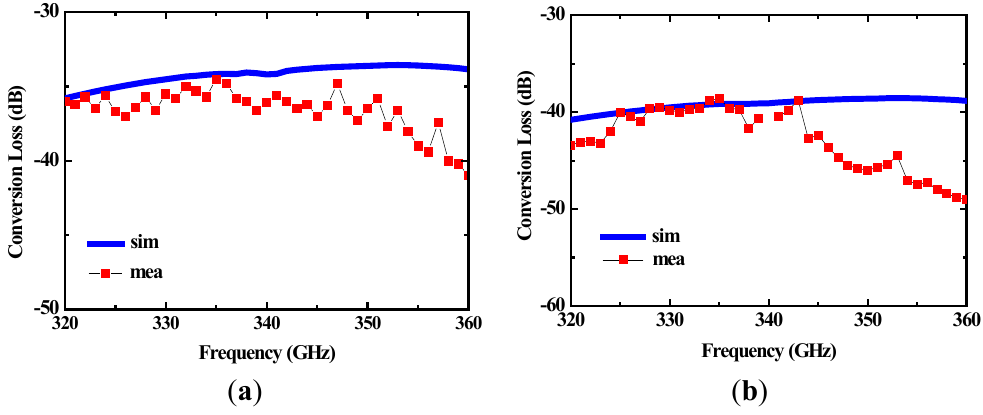
Figure 6. Simulated conversion loss and noise figure (NF) versus LO power: ( a ) 2× SHM and ( b ) 4× SHM.